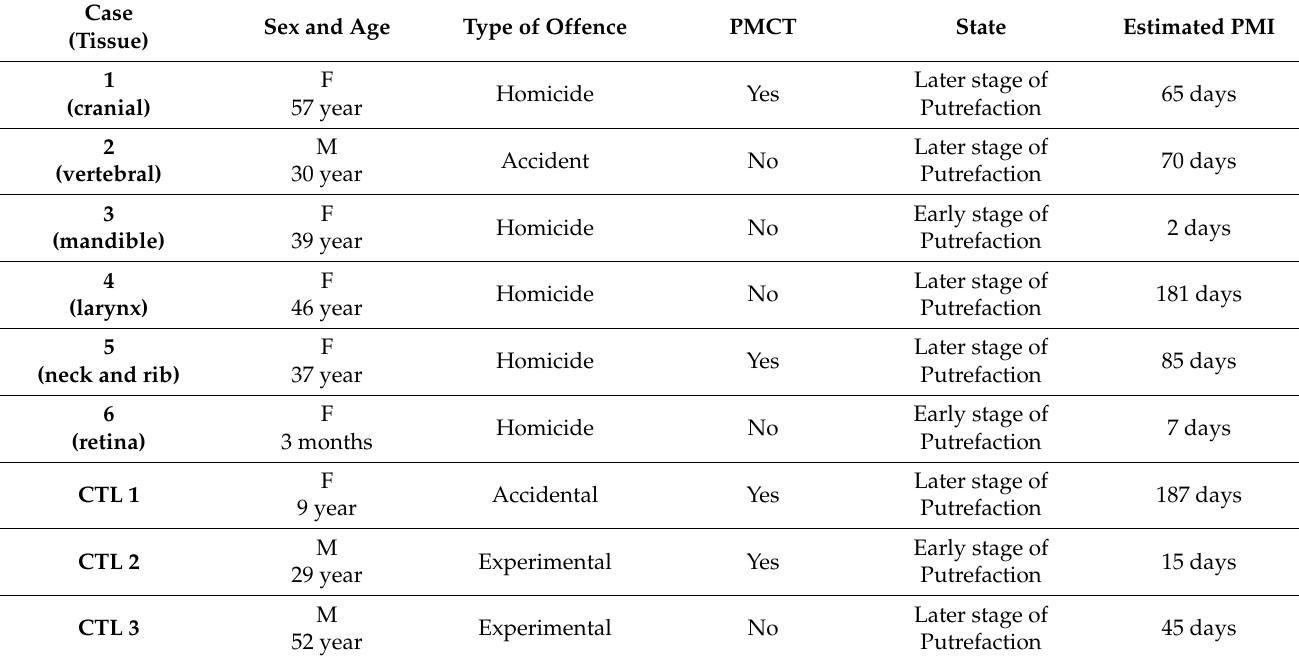
Table 1. The main characteristics of the selected case. PMCT: Post-mortem computed tomography; PMI: Post-mortem interval; CTL: